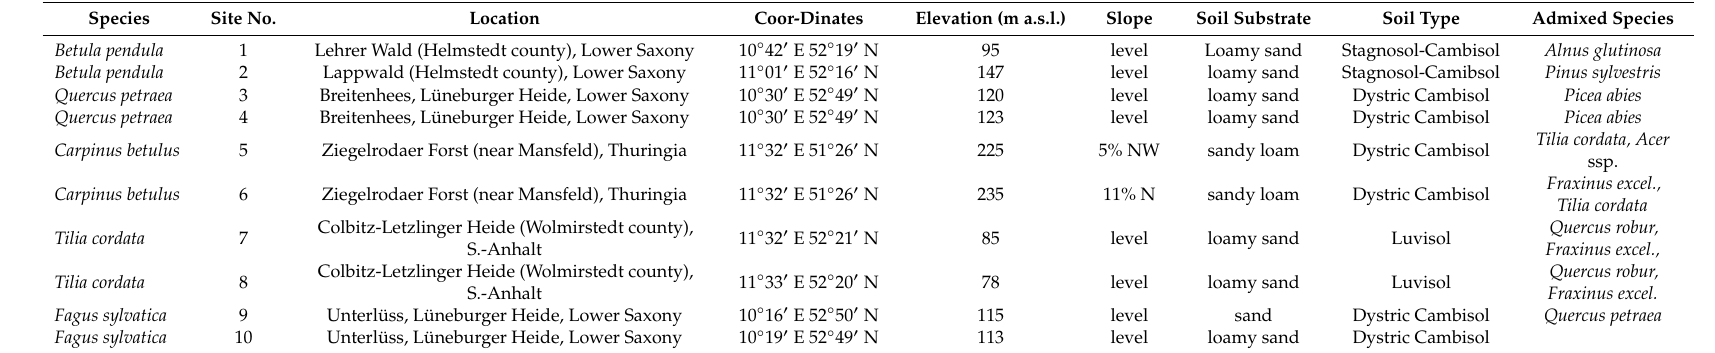
Table 3. Some physiographic and stand structural characteristics of the study sites in northern and central